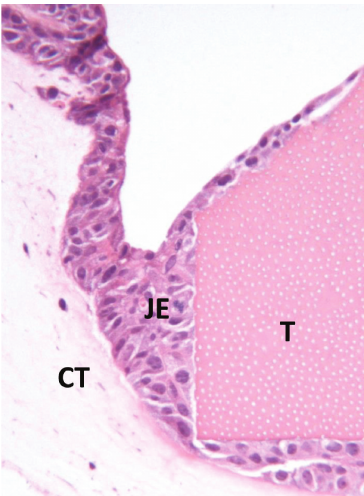
Figure 4: Organotypic culture model of the JE shows the structures of the dentogingival junction, JE = in vitro junctional epithelium, T = tooth, CT = connective tissue. When biofilm is placed on the top of the model host-bacteria interaction can be